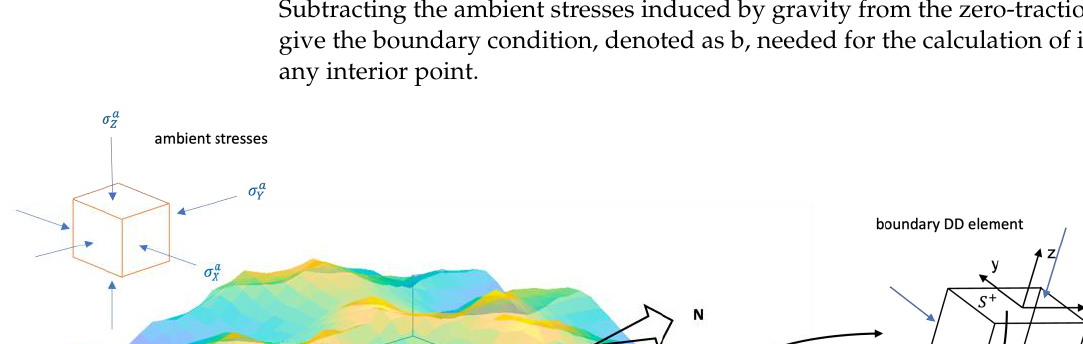
Figure 2. Schematic diagram of the basic configuration of a DDM model. The global DD plane and the domain are plotted on the left in global axes; an enlarged individual DD element on the topo- graphic surface is plotted on the right in local axes. The traction-free condition on the exposed sur- face is visualized with the figure at the bottom for such a boundary DD element. Note that the DD element is not drawn to scale as its thickness is considered negligible compared to its lateral extent.